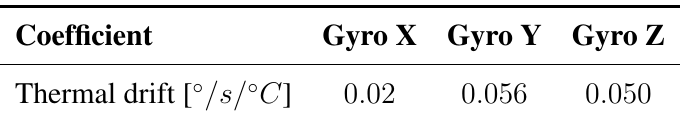
Figure 3. Thermal drift regression for Z gyros axis. ( a ) Temperature correlated bias and linear regression curve; ( b ) Residual information of the fitted